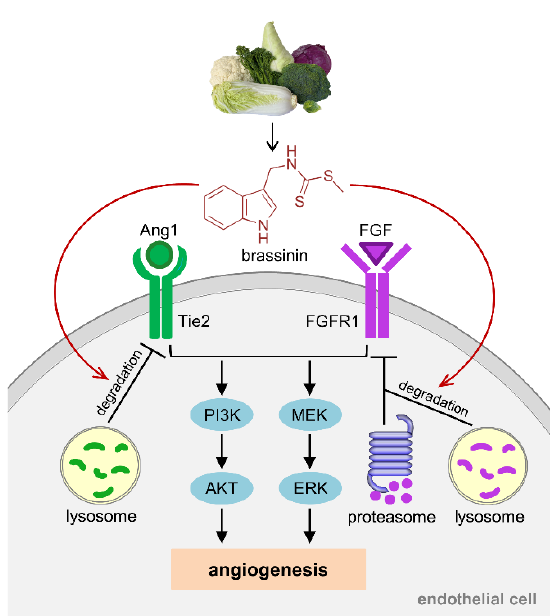
Figure 7. Schematic diagram representing the molecular mechanisms underlying the anti-angiogenic effects of brassinin. Brassinin stimulates the lysosomal degradation of Tie2 as well as the lysosomal and proteasomal degradation of FGFR1 in endothelial cells. This results in the down-regulation of the AKT and ERK pathway and, thus, the inhibition of angiogenesis.